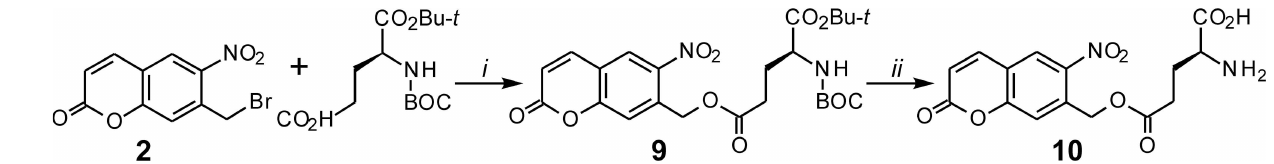
Fig 3. Synthesis of γ - O -Ncm-Glu (glutamate caged on the γ -carboxyl group). Reagents and conditions: i ) Et 3 N, DMSO, rt, 5.5 h; ii ) TFA, CHCl 3 , rt, 21 h.